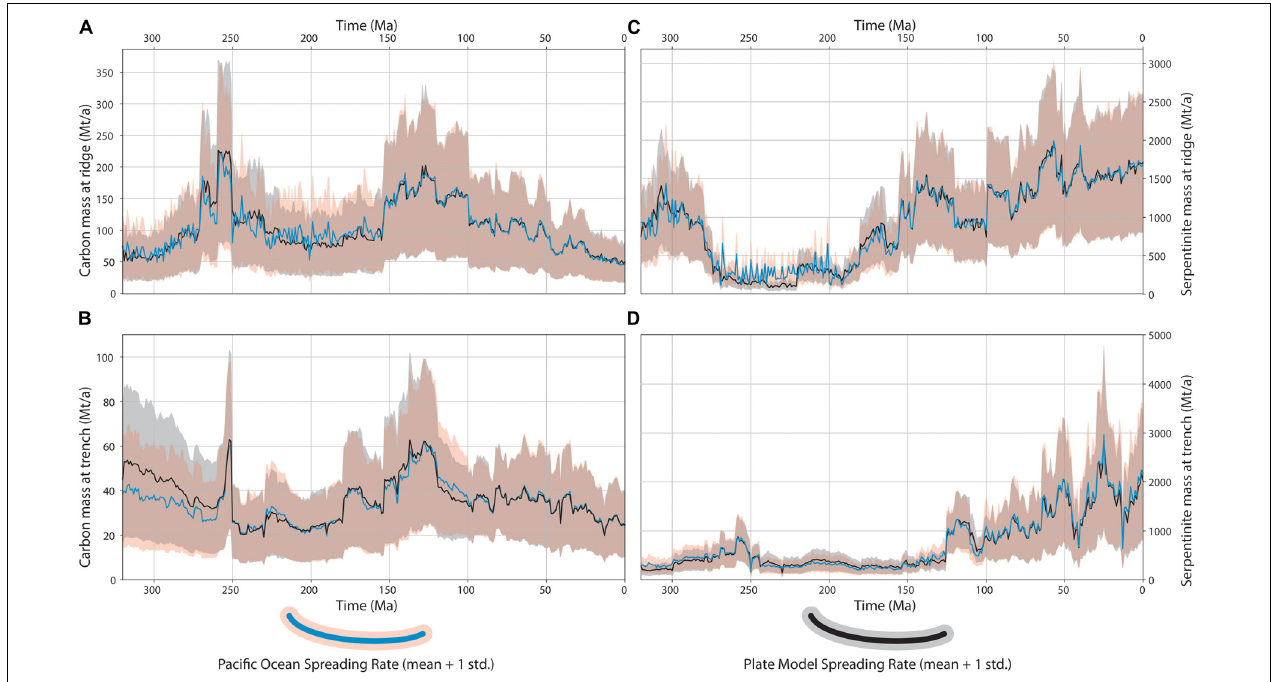
FIGURE 10 | Comparison of two approaches used in this analysis, POSR (red shaded area and blue line are one standard deviation and mean, respectively), and PMSR (gray shaded area and black line are one standard deviation and mean, respectively). (A) Carbon sequestration at ridges in altered ocean lithosphere, (B) carbon mass in altered ocean lithosphere at trenches, (C) serpentinite mass from altered mantle peridotite at ridges, and (D) serpentinite mass in altered mantle peridotite at